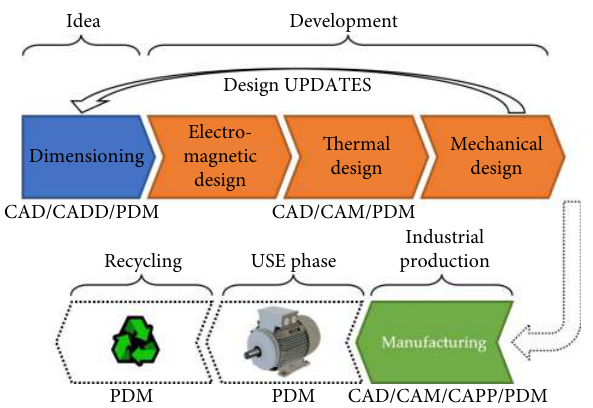
Fig. 6 Lifecycle of electric